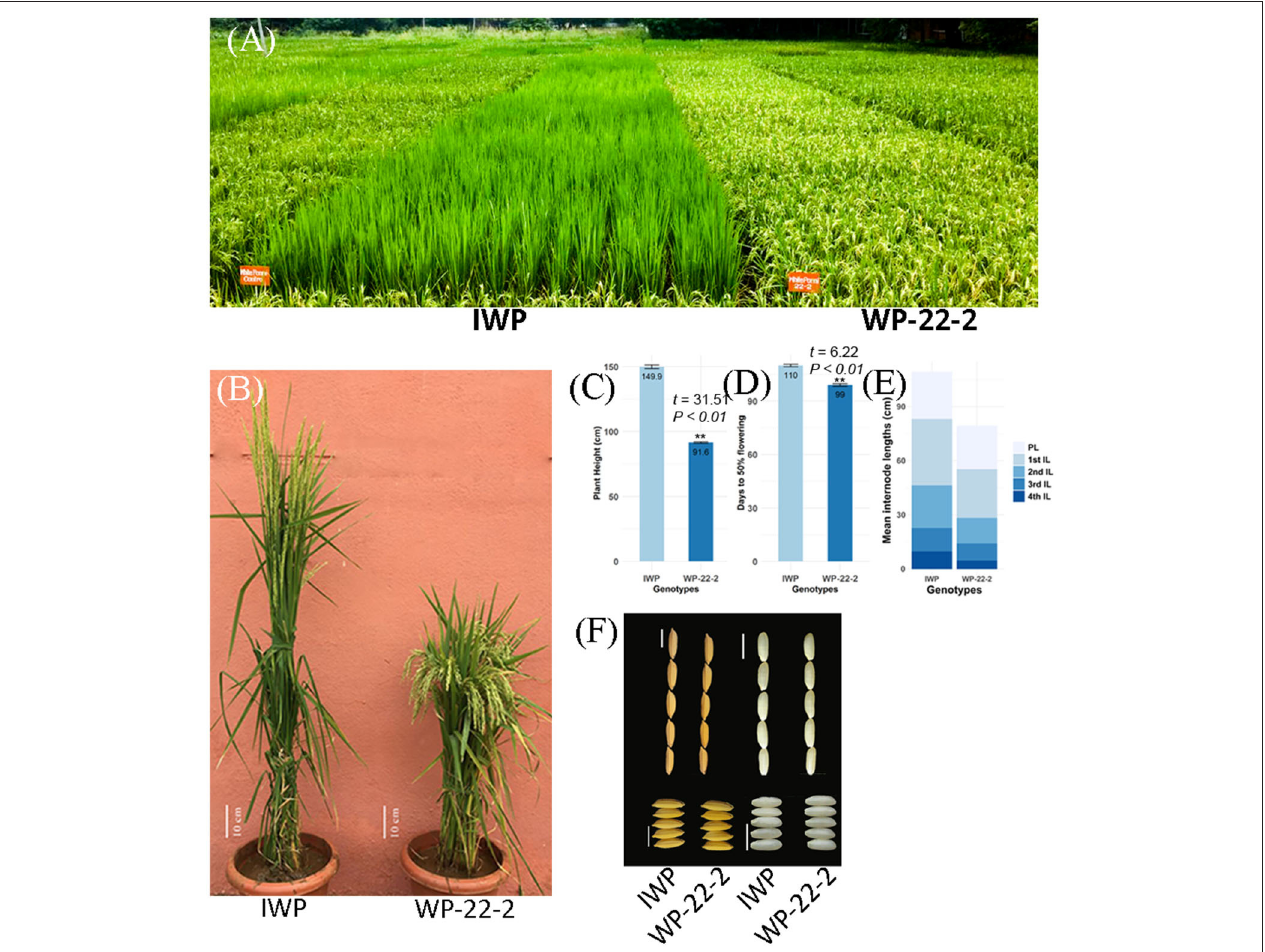
FIGURE 1 | Comparison between the rice variety Improved White Ponni (IWP) and superior mutant WP-22-2. (A) Field view of IWP and WP-22-2. IWP is clearly tall and still in vegetative stage, whereas WP-22-2 is dwarf and has already reached maturity. (B) Plants of IWP and WP-22-2 (scale bar: 10cm). (C,D) Barplot showing difference in days to 50% flowering and plant height between c- IWP and m-WP-22-2. (E) Comparison of internode and panicle lengths of IWP and WP-22-2. (F) Length and breadth of rice grains of IWP and WP-22-2 (scale bars: 5